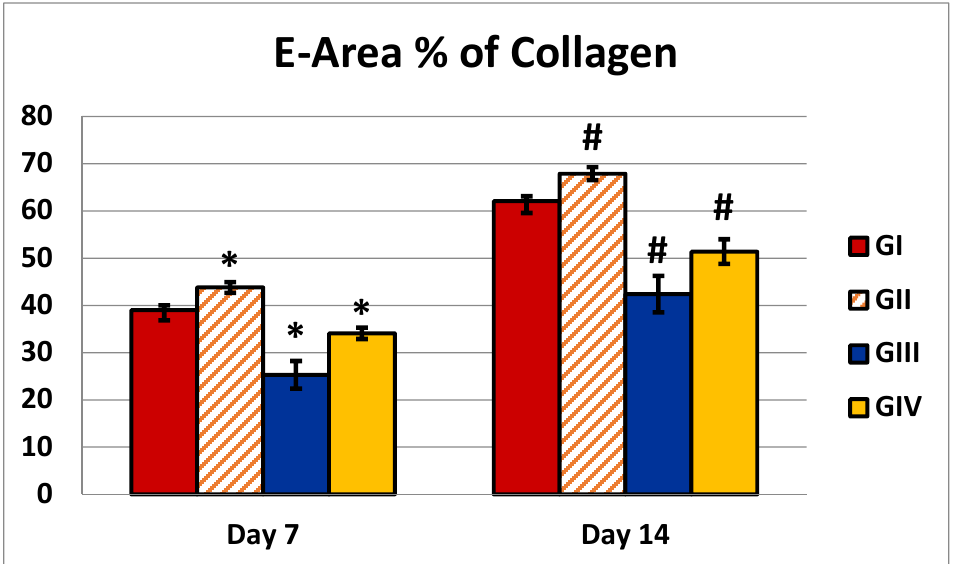
Figure 10 . Sections obtained from skin wound on day 14. ( a ) Untreated wound revealed regular moderate collagen fibers. ( b ) DEEL-treated wound exhibited thick regular collagen fibers. ( c ) MRSA-infected wound showed scattering irregular collagen fibers ( d ) MRSA-infected + DEEL treated wound showed immature irregular collagen fibers (Mallory trichromeX200).